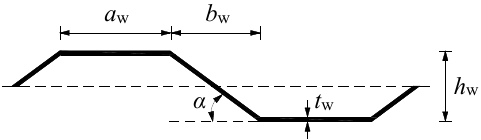
Figure 1. Geometric shape of a corrugated steel web.